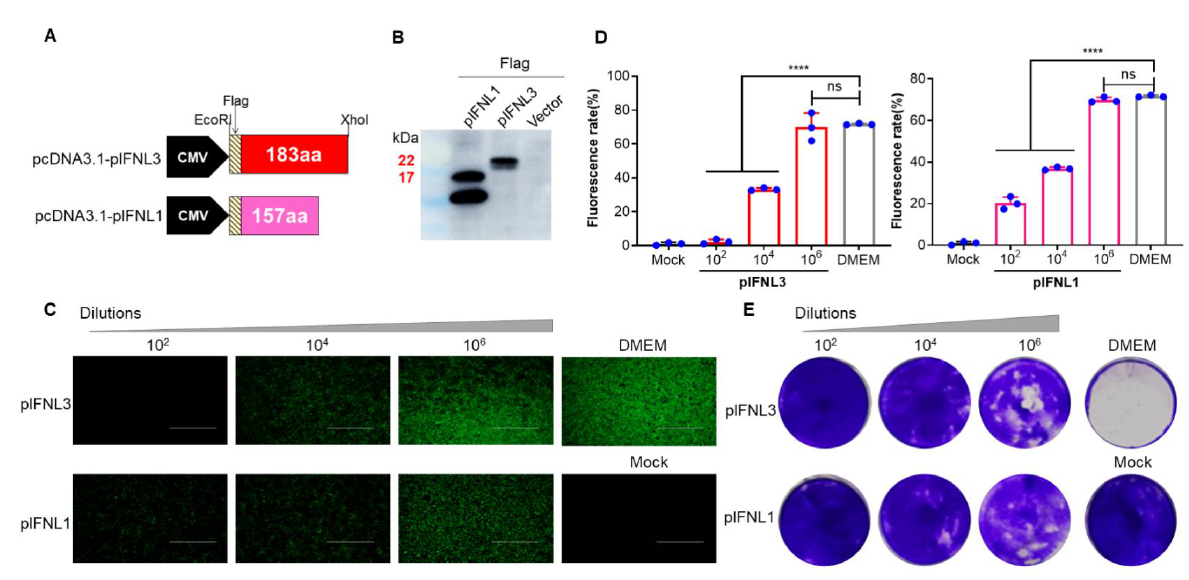
Figure 1. Preliminary analysis of antiviral activities of pIFNLs. ( A ) Schematics of the two recombinant plasmids pcDNA3.1-pIFNLs. ( B ) Expression of pIFNLs identified by WB. ( C ) The identified